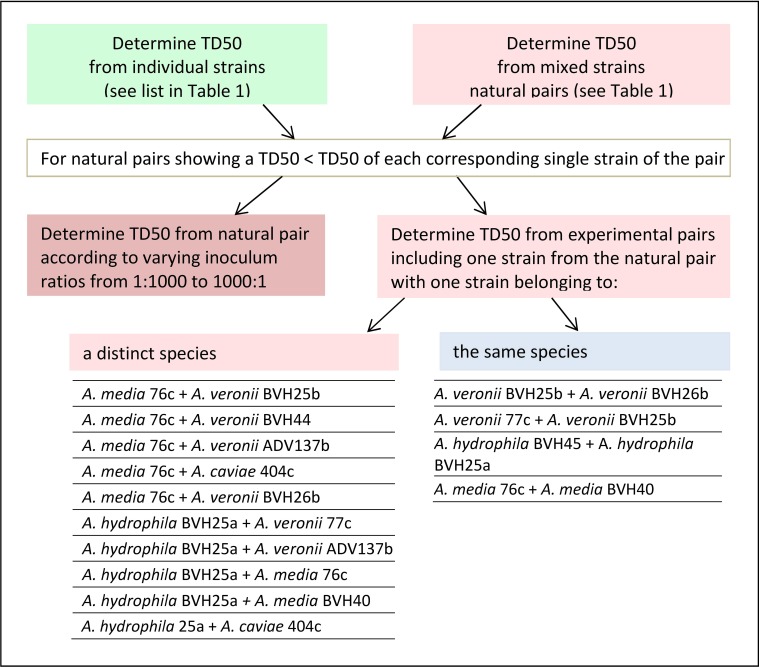
Flowchart showing the sequential nematode killing assays (NKA). The median time to worm death (TD50) determinations were performed for single and paired strains according to the type of pair (naturally recovered or experimentally associated), and, for experimental pairs, according to the type of species pairing (same species or different species).